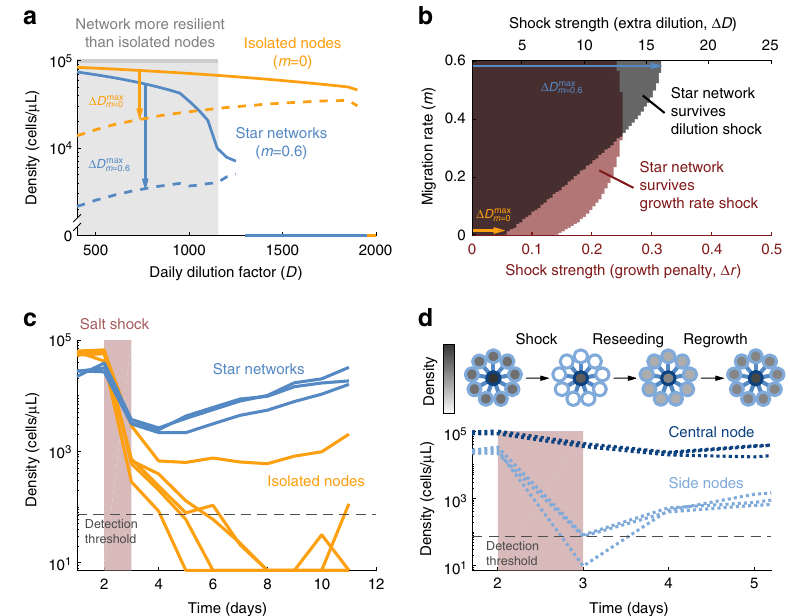
Fig. 4 Star networks are more resilient to perturbations than isolated populations. a Bifurcation diagram for the metapopulation. Solid lines show the average population density in equilibrium as a function of dilution rate (yellow: isolated nodes; blue: 10-node star network). Dashed lines show the minimum density from which the metapopulation can recover. Arrows show the maximum dilution shock that each metapopulation can withstand ( Δ D max ), when daily dilution rate is D = 750. Gray area marks the region where the star network can withstand a greater shock than the isolated nodes. Model parameters are as in Fig. 2. See Supplementary Figure 3 for a more detailed version of this fi gure. b Model prediction for survival of a 10-node star network with daily dilution factor D = 750 after a perturbation, as a function of perturbation strength and migration rate. Rest of parameters are as in Fig. 2. Black: Shock corresponds to one cycle with increased dilution factor, D ’ = 750* Δ D . Red: Shock corresponds to one cycle with reduced growth r ’ = 0.5 - Δ r . c Experimental results showing the time evolution of the average density in star networks (blue) and isolated populations (yellow). Each line corresponds to one 10-node network or to 10 isolated nodes. All populations are subject to a 750 dilution factor and are initially in equilibrium. They are then perturbed by a salt shock (32 g/L concentration of NaCl, shaded in red). d Top: Cartoon of star network recovering from a perturbation. Grayscale indicates population density in every node. Bottom: Same as b , but only for the star network and separating the center and side